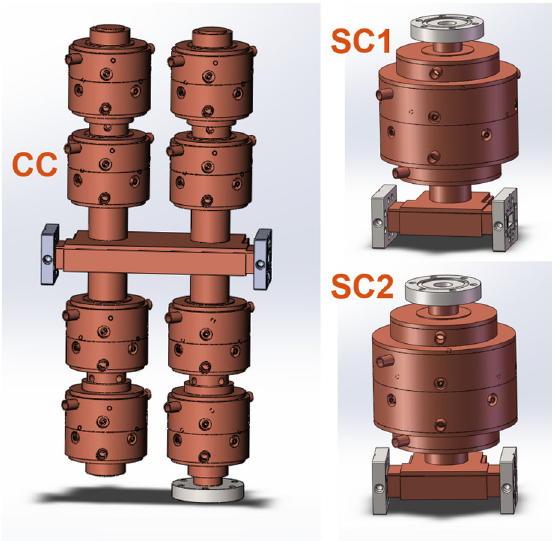
FIG. 7. Mechanical design of the correction cavity chain and storage cavities.